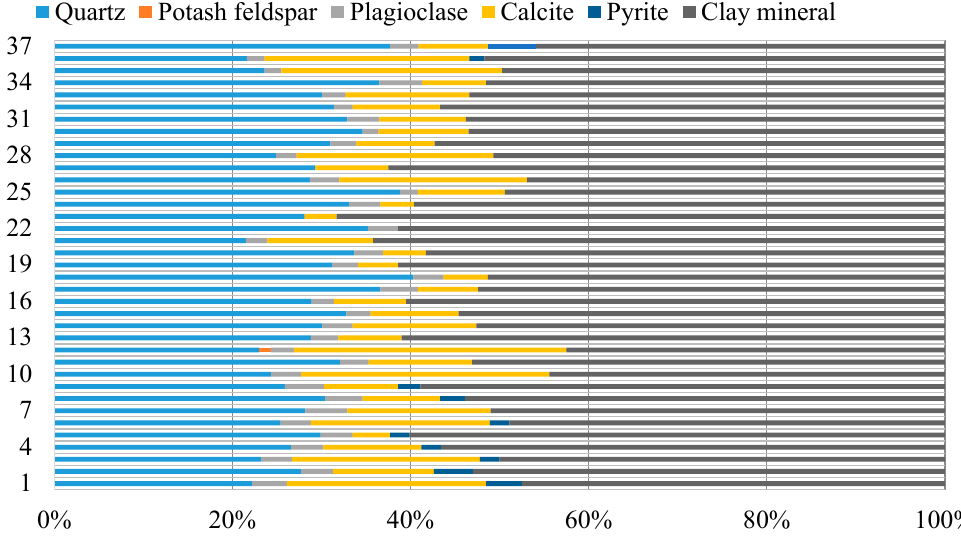
Figure 2. The distribution of shale mineral composition in the Da’anzhai section, FY1 Well.